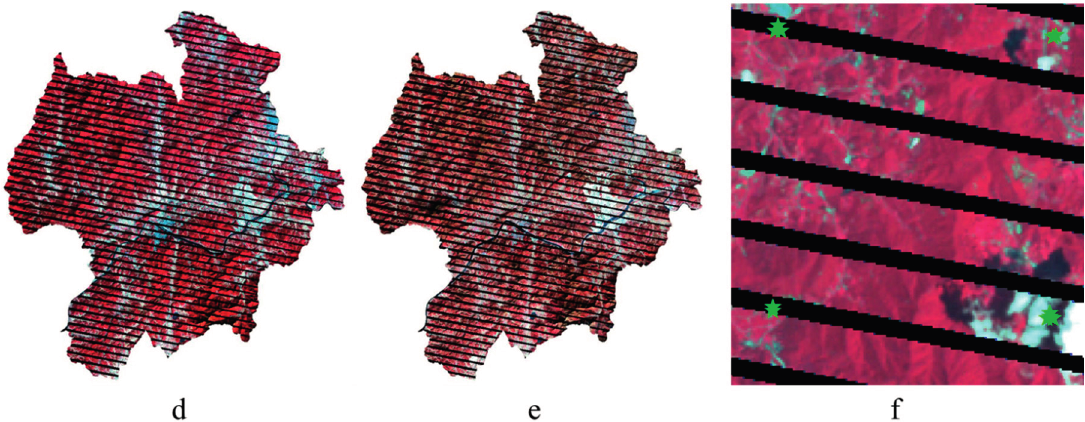
Figure 2. Quality of five seasonal images in infrared composition and study area: ( a ) 4th April 2011; ( b ) 20th May 2011; ( c ) 8th August 2010; ( d ) 24th October 2009; ( e ) 15th November 2011; ( f ) NFI samples from no-data area (black) due to SLC-off ETM+ images, cloud cover or shadow were